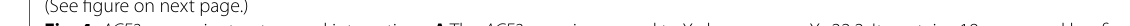
(receptor-mediated) among others in biological process category (Fig. 6A), host cell surface binding, virion bind- ing, and virus receptor activity in the molecular function